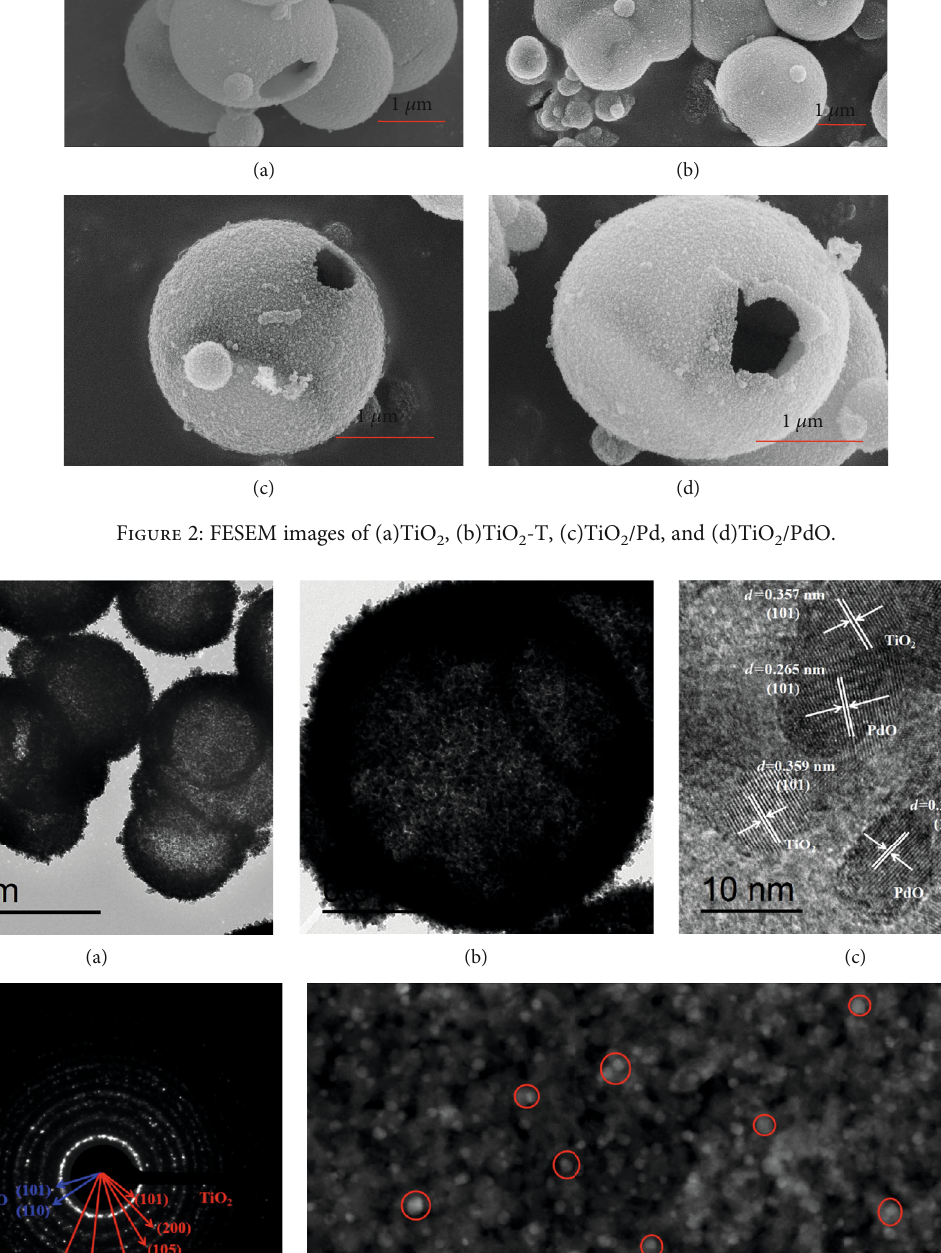
Figure 3: TEM (a, b), HRTEM (c), SAED (d), and STEM (e) images of TiO